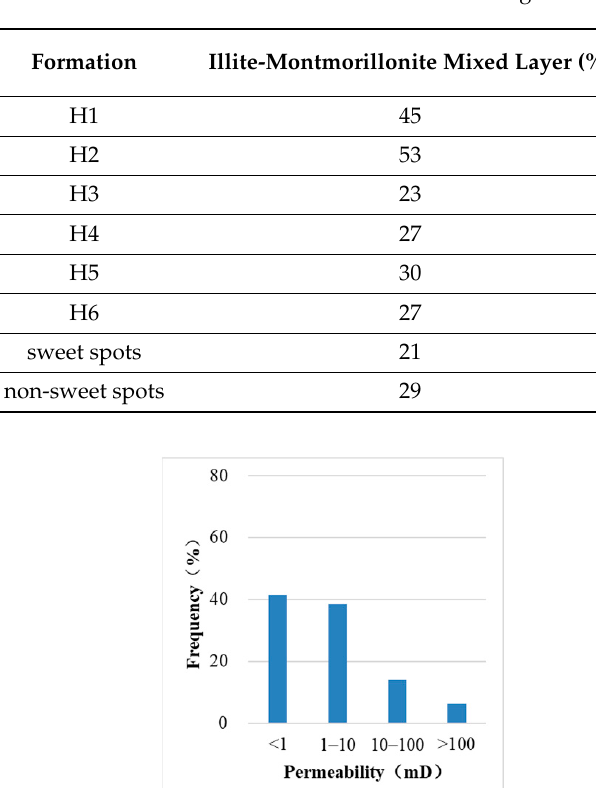
Table 1. Data of average relative content of clay minerals in the X gas field.